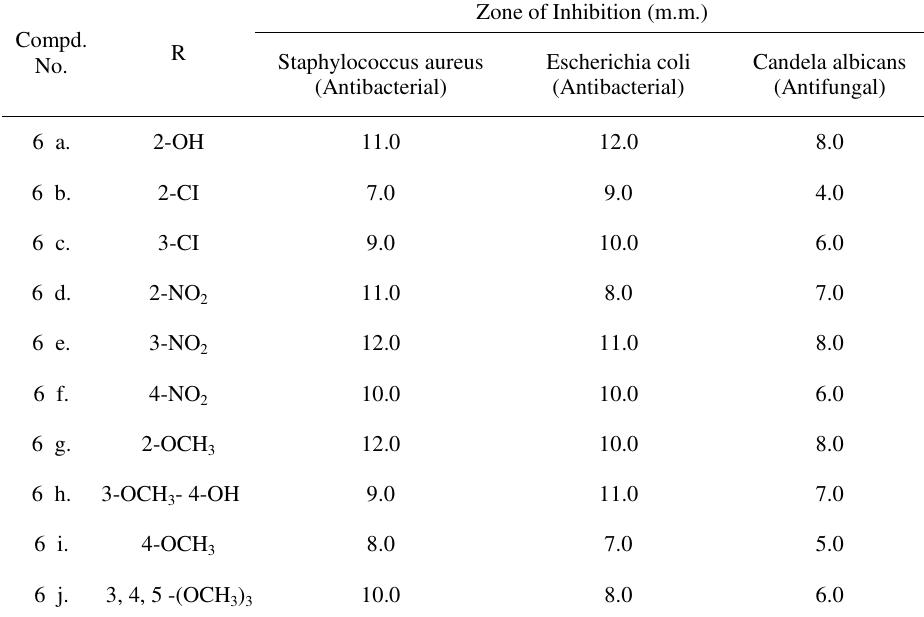
Table 12. ANTIMICROBIAL DATA OF COMPOUNDS [6(a-j)]